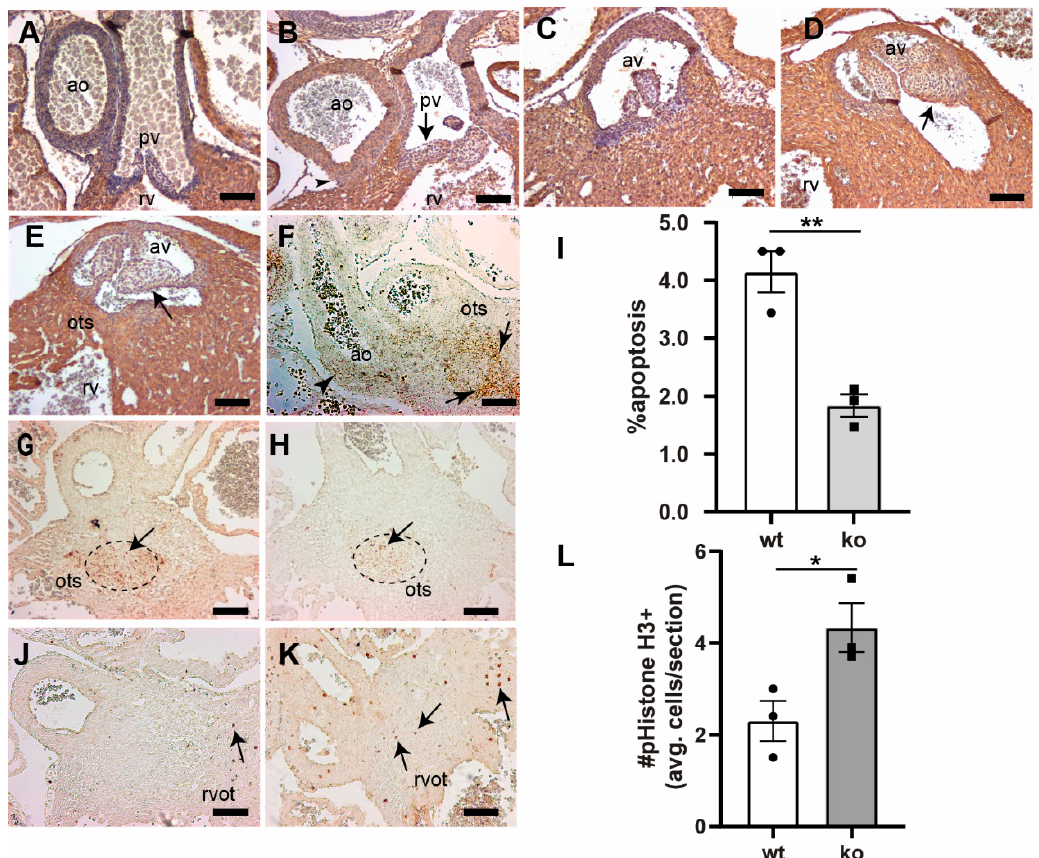
Figure 3. Loss of Tgfb3 in mice results in the outflow tract cushion and vascular wall defects. A – E , Cross-sections of